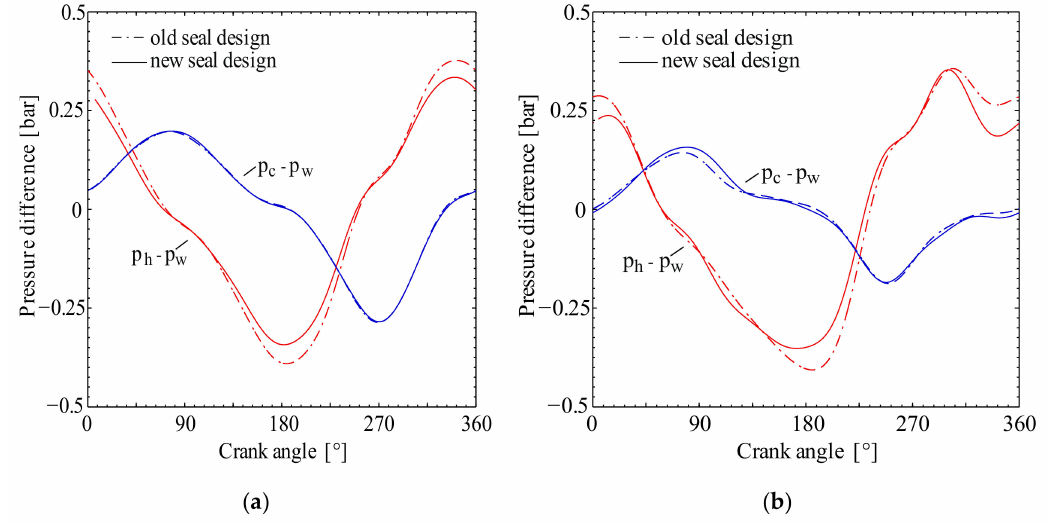
Figure 6. Measured pressure di ff erences between the temperature levels with the old and the new seal design at nominal conditions in: ( a ) Vuilleumier mode and ( b ) Stirling mode.